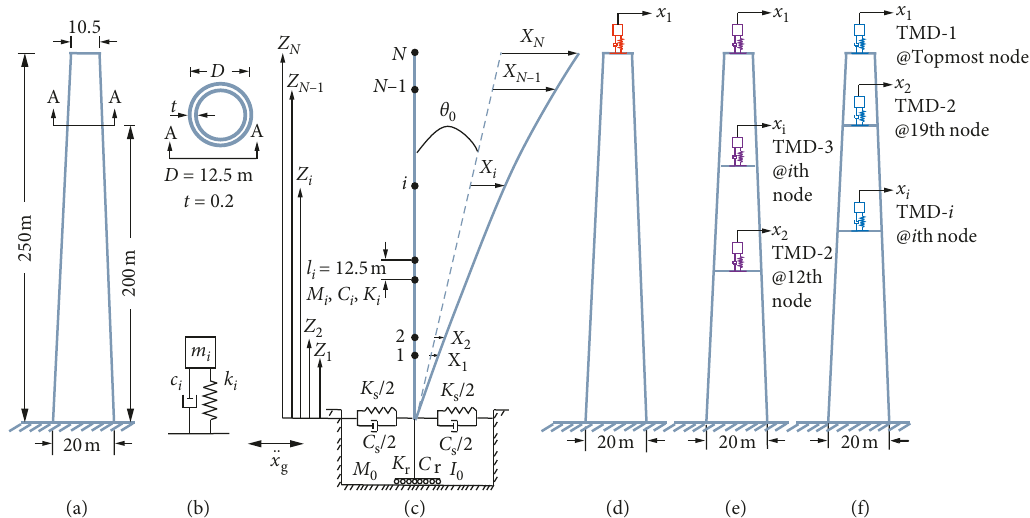
Figure 1: (a) Details of the chimney with no control, i.e., uncontrolled (NC); (b) schematic diagram of TVA and section A-A; (c) lumped mass idealization for the chimney including SSI and installed with (d) STVA, (e) ad-MTVAs, and (f)